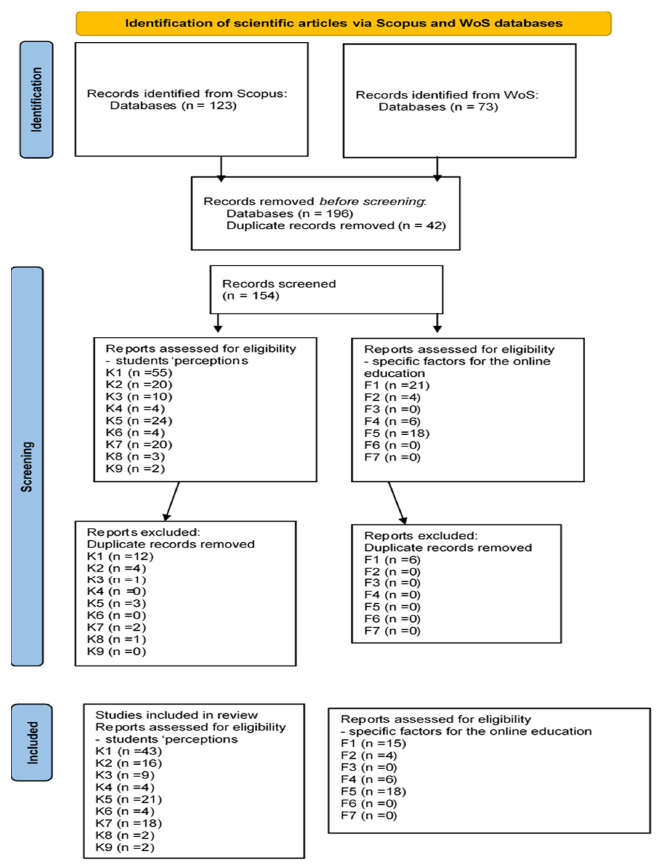
Figure 1. Prisma flow chart: student perceptions of online education. Source: authors’ own analysis.